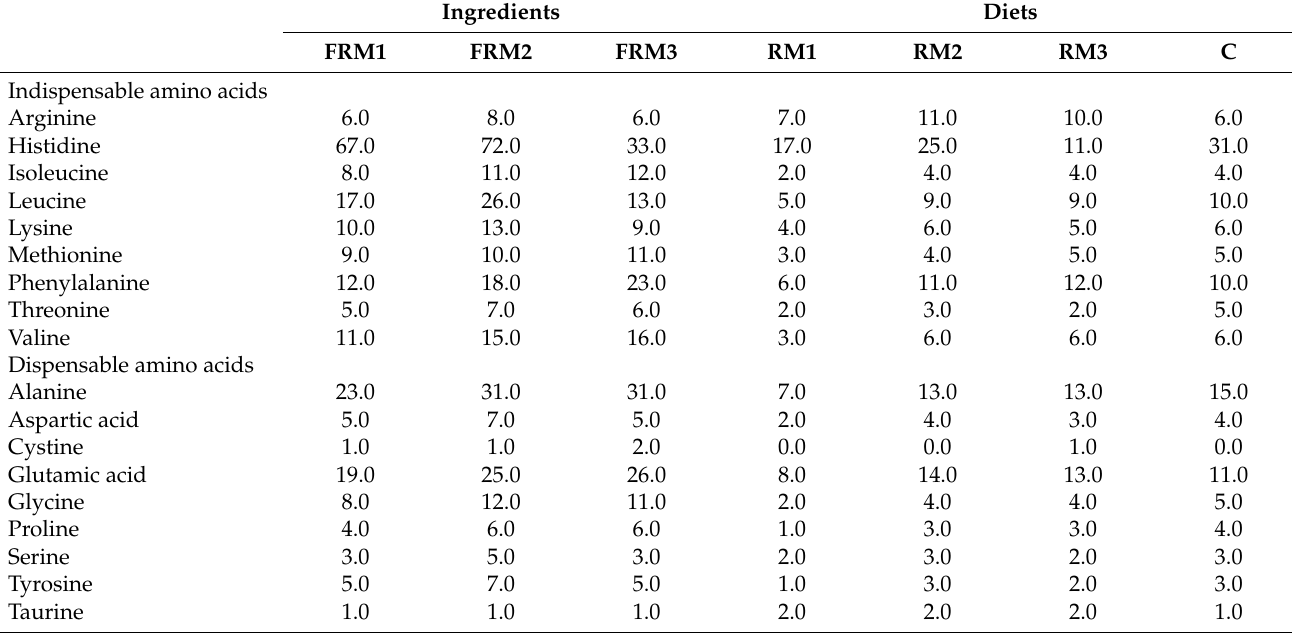
Table 5. Free amino acid and taurine contents (mg/100 g, dry basis) of ingredients and diets used In Trials 2 and